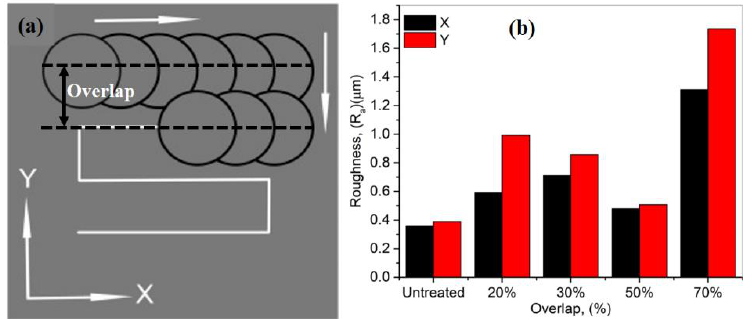
Figure 10. ( a ) Schematic of successive laser-shots with laser scan overlap and ( b ) overlap (%) effect on the surface roughness [64]; with permission from